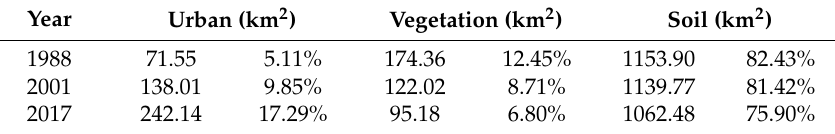
Figure 4. The changes of urban land and vegetation cover in the study area from 1988 to 2017. Table 4. The proportion of the urban land, vegetation cover and soil in the study area.